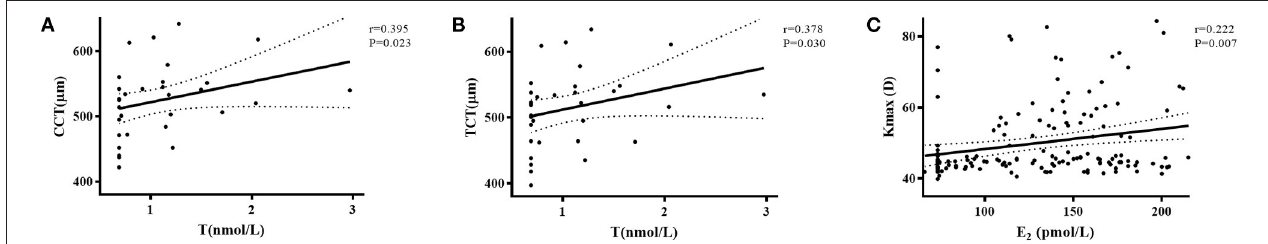
FIGURE 2 | The correlation of plasma sex hormone levels to CCT, TCT, and K max in female and male groups. (A) The level of T positively correlated with CCT ( r = 0.395, P = 0.023) in female patients. (B) The level of T positively correlated with TCT ( r = 0.378, P = 0.030) in female patients. (C) The level of E 2 positively correlated with K max ( r = 0.222, P = 0.007) in male